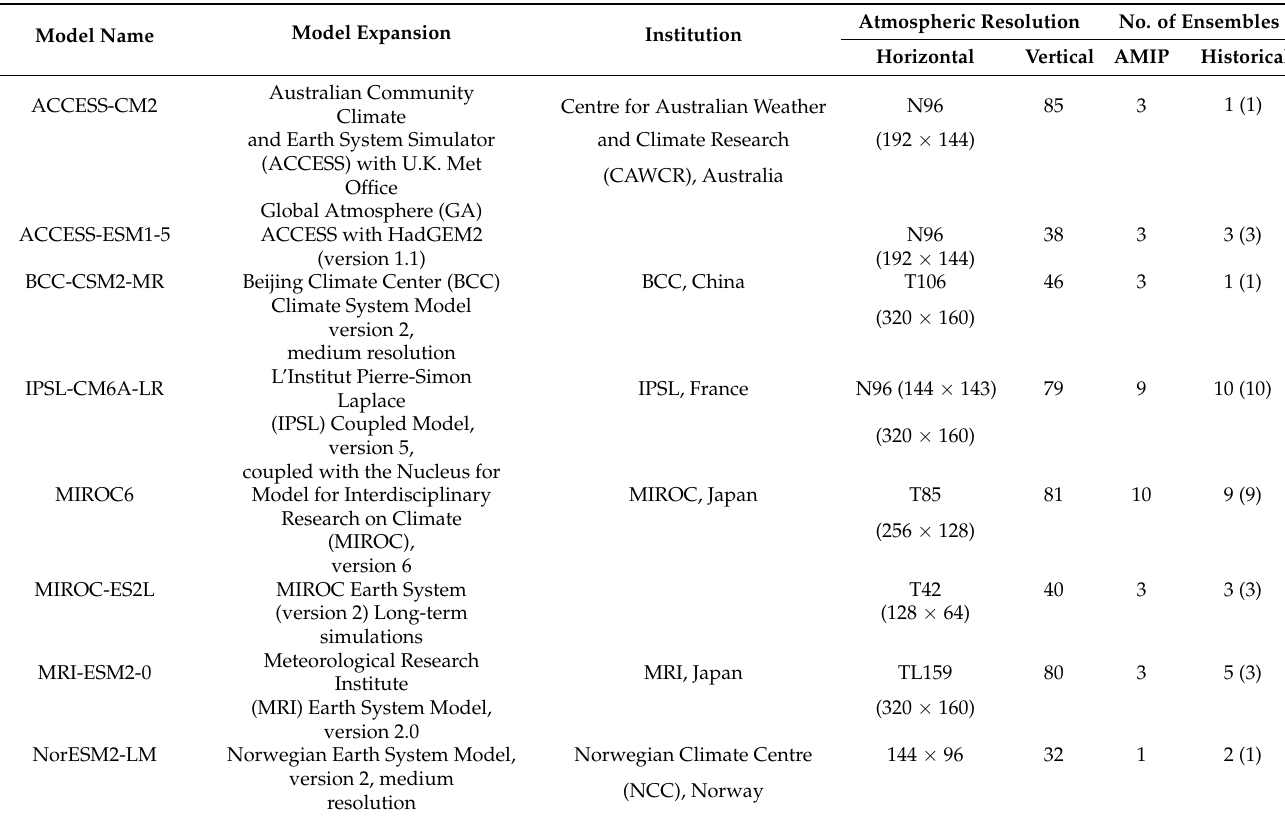
Table 1. List of CMIP6 models used in this study, including the model-developing institution, the horizontal and vertical resolution of the atmospheric component, and the number of ensembles for the AMIP6 and CMIP6 simulations with respect to the 250 hPa horizontal winds and sea surface temperature in parentheses. The resolution of spectral models is first indicated by the truncation type (T—triangular truncation, TL—triangular linear truncation, R—rhomboidal truncation, C—cubed- sphere finite volume, N—number of Gaussian grid points, F—finite volume grid), followed by the truncation number, dimension of the model output on a Gaussian grid (in parentheses), and the approximate nominal resolution (in km). The resolution of the grid point models is indicated by the grid